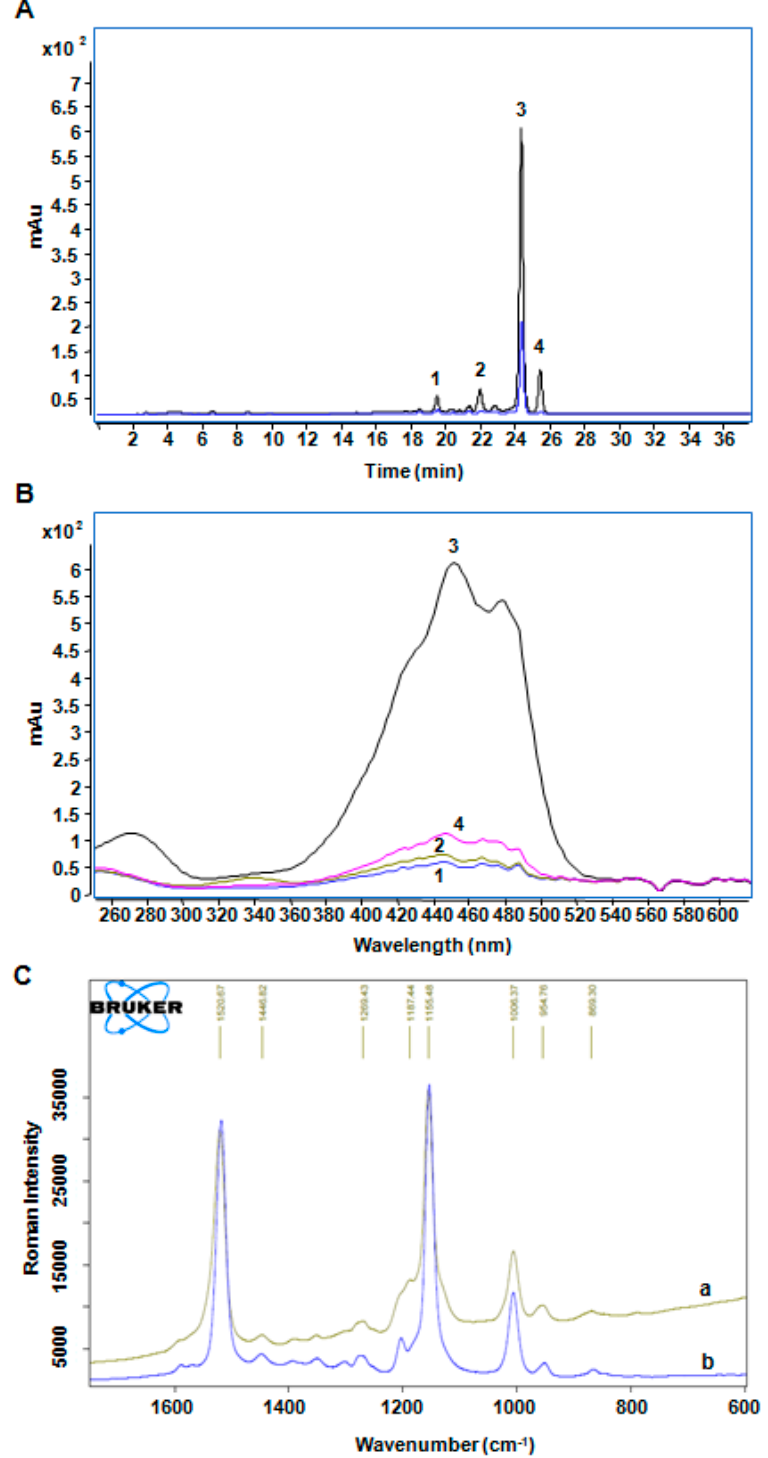
Figure 2. The products of β -carotene treated with BMFDS under UVA irradiation. HPLC chromatograms ( A ) and UV-Vis spectra ( B ) of β -carotene oxidation products induced by BMFDS treatment for 5 min in ethanol under UVA irradiation. The blue line in HPLC chromatograms is referred to standard β -carotene. Peak identification for ( A ) and ( B ): Peak 1, all- trans -5,6-expoxy- β -carotene; Peak 2, 13- cis - β -carotene; Peak 3, all- trans - β -carotene; Peak 4, 9,13-di- cis - β -carotene. Raman spectra ( C ) at different wave number corresponded to β -carotene under UVA irradiation for 5 min with BMFDS ( a ) and without BMFDS ( b ),